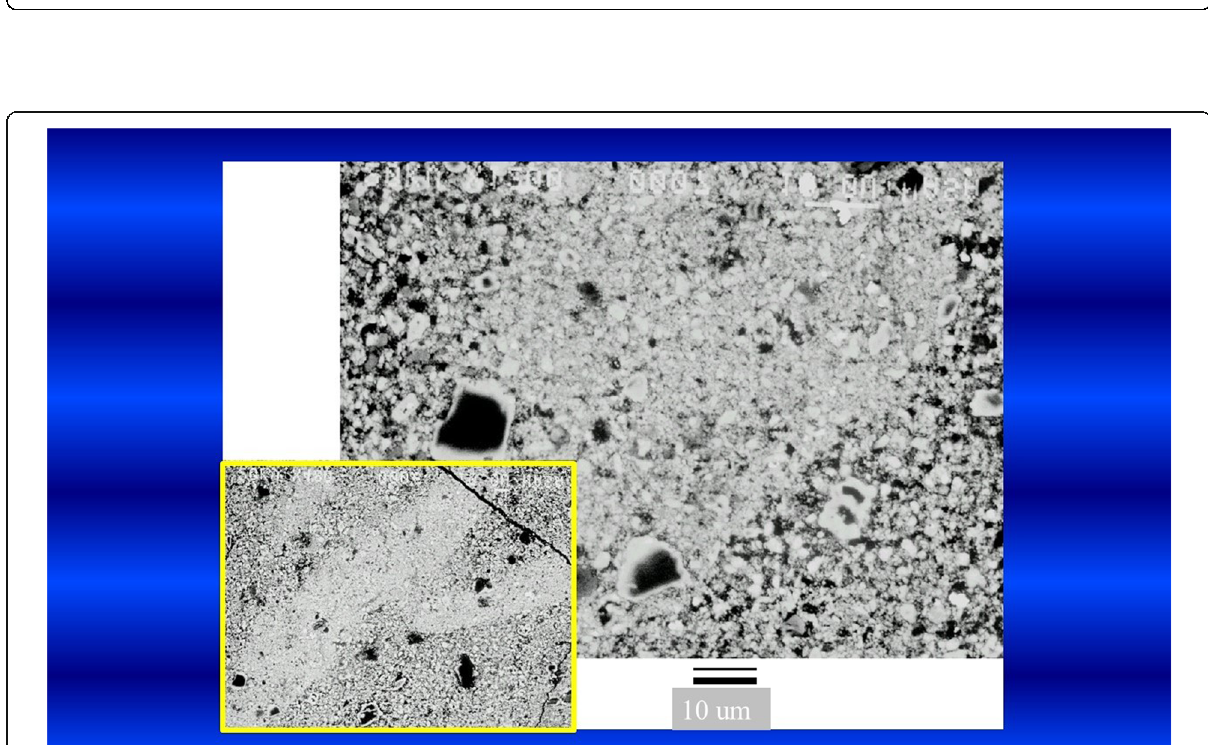
Fig. 17 Backscattered electron image of a portion of a pond deposit clast from the Vigarano CV3 chondrite. The mineralogy of the clast is mainly olivine, with Fe-rich olivine being lighter in shade. Sedimentary beds are apparent, and light gray (Fe-olivine-rich) layers are at the bottoms of the beds. Crossbeds are